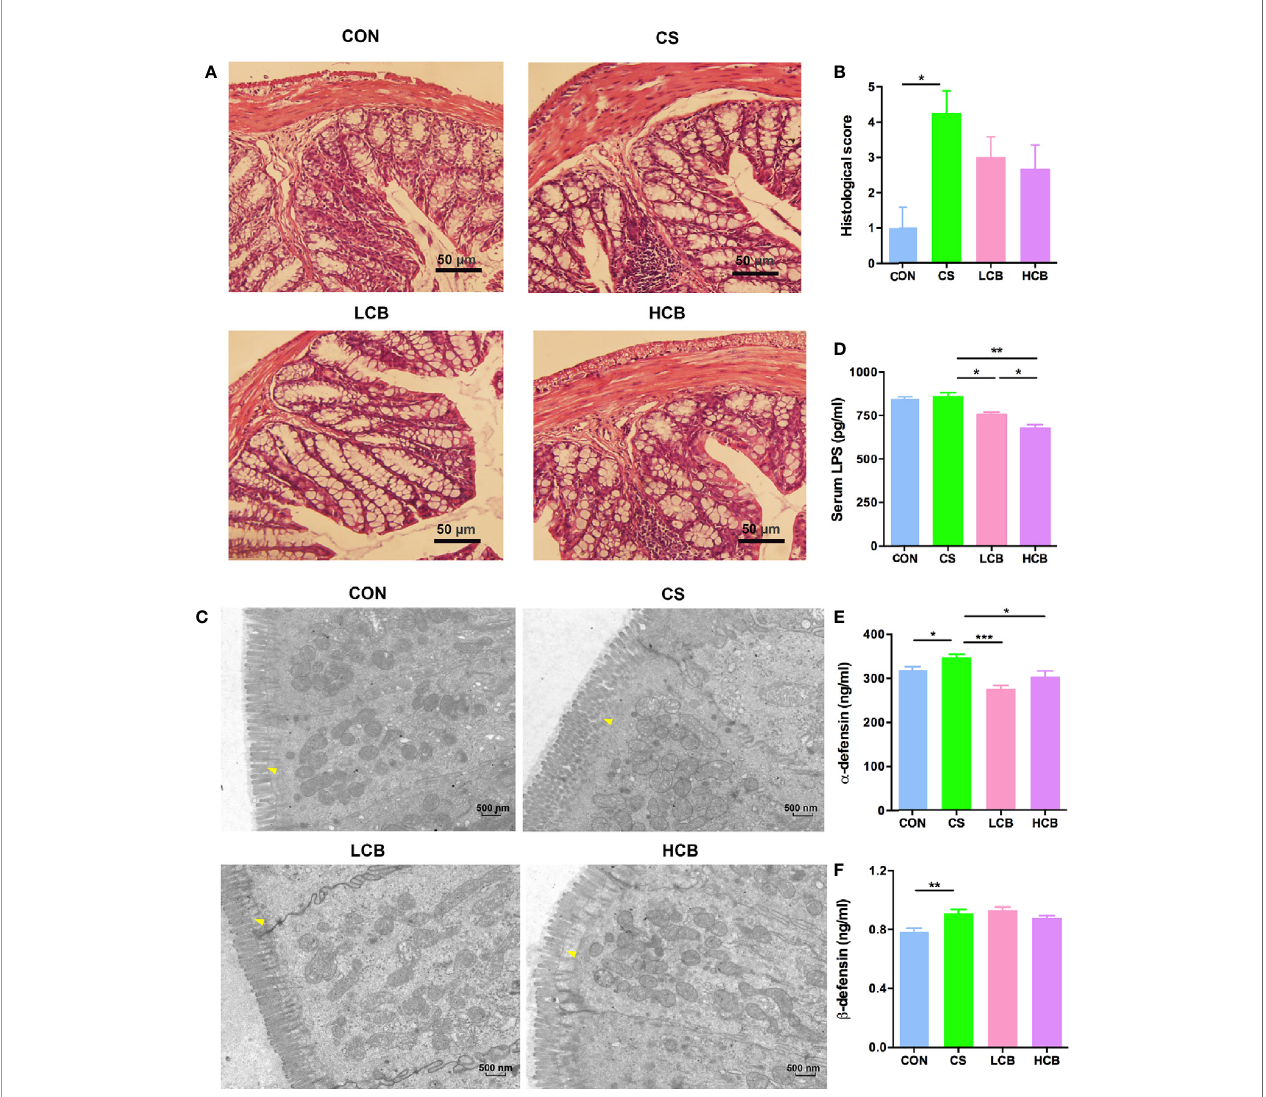
FIGURE 3 | CB RH2 changes the mechanical barriers in intestinal mucosa of ceftriaxone-treated mice. (A) H&E-stained results for the sections of mouse colon; (B) Histopathological analysis of the H&E-stained sections; (C) Transmission electron microscopy (TEM) analysis of colon; (D) LPS of serum were detected by ELISA following the manufacturer ’ s protocol; (E, F) The concentrations of a -defensin and b -defensin in colon of mice. All data were evaluated as mean ± SEM (n = 5), *p <0.05, **p <0.01, ***p